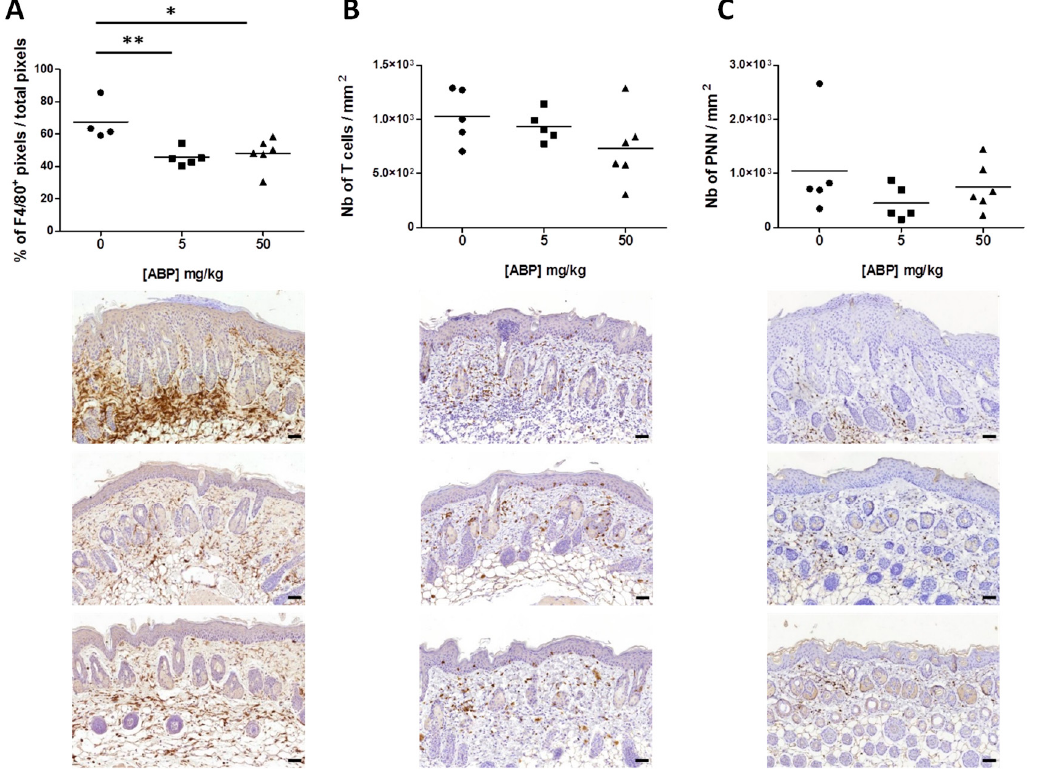
Figure 6. Immunological assessment of the efficacy of the ABP dendrimer when administered topically to IMQ-induced psoriatic mice. Quantification of the infiltration of F4/80-positive cells (mainly macrophages) ( A ), T lymphocytes ( B ), and polynuclear neutrophils ( C ) in the skin of the back of each group of mice ( n = 5 mice in the control group at a concentration of ABP = 0 mg/kg, n = 5 mice for the group at 5 mg/kg, and n = 6 mice for the group at 50 mg/kg) by immunohistochemistry; * p < 0.05, and ** p < 0.01 versus untreated mice (concentration of ABP = 0 mg/kg) using the one-way ANOVA test followed by the post hoc Dunnett’s test. Below each graph, representative immunochemistry pictures of the skin of the back of mice at day 7 from psoriatic control mouse, and mice treated daily with 5 mg/kg and 50 mg/kg of the ABP dendrimer, from top to bottom, respectively, are shown; black scale bars represent 50 µm.